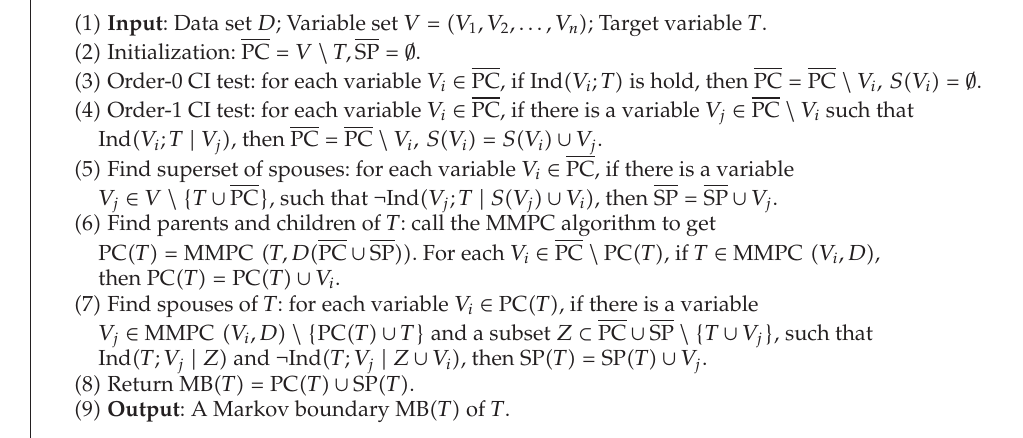
Algorithm 2: Algorithm for discovering Markov